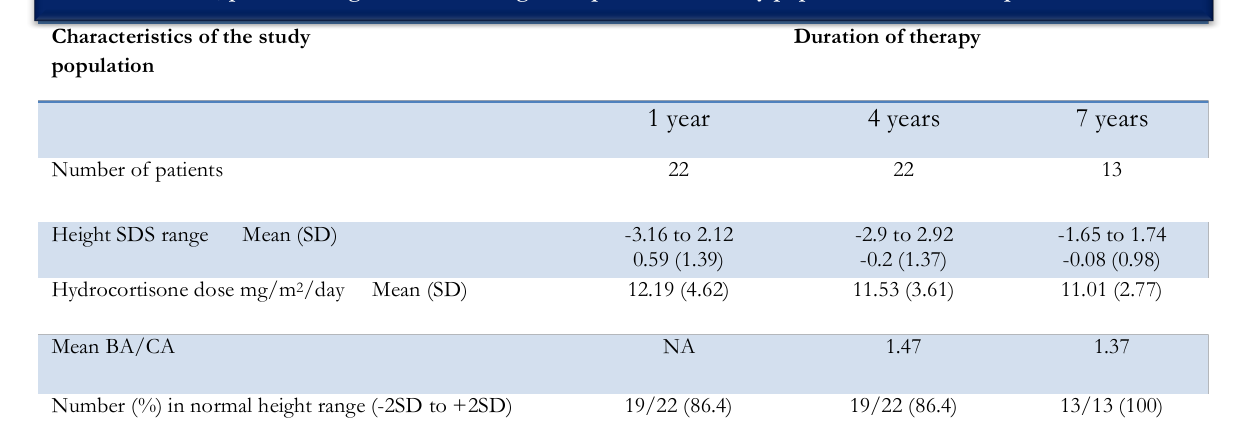
Table 3: Clinical, pharmacological and radiological aspects of the study population at different